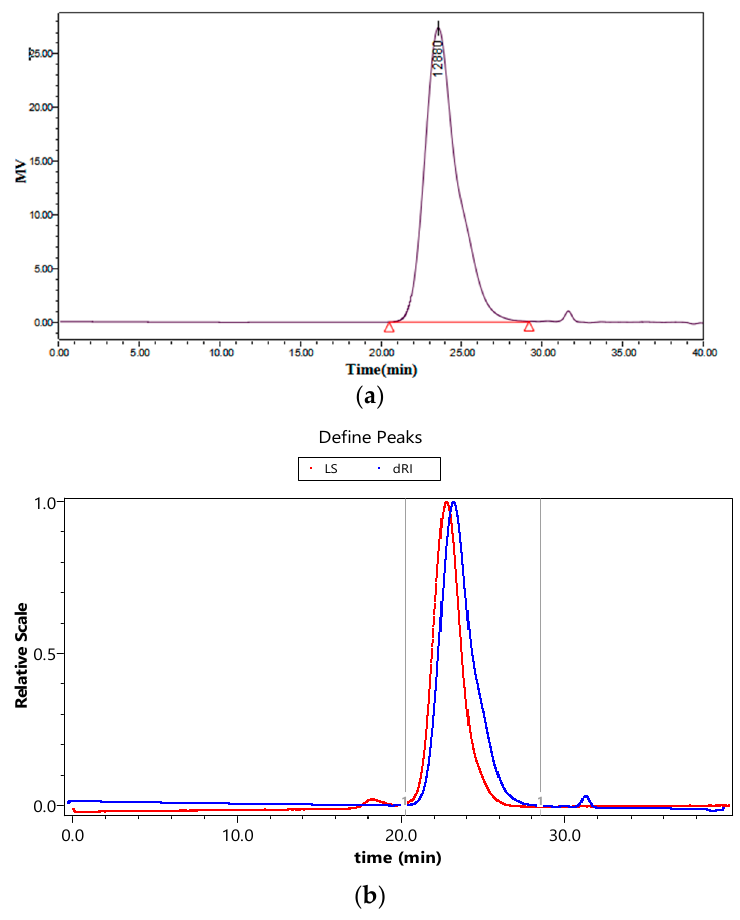
Figure 7. Chromatograms of GPC ( a ) and GPC-MALS ( b ).